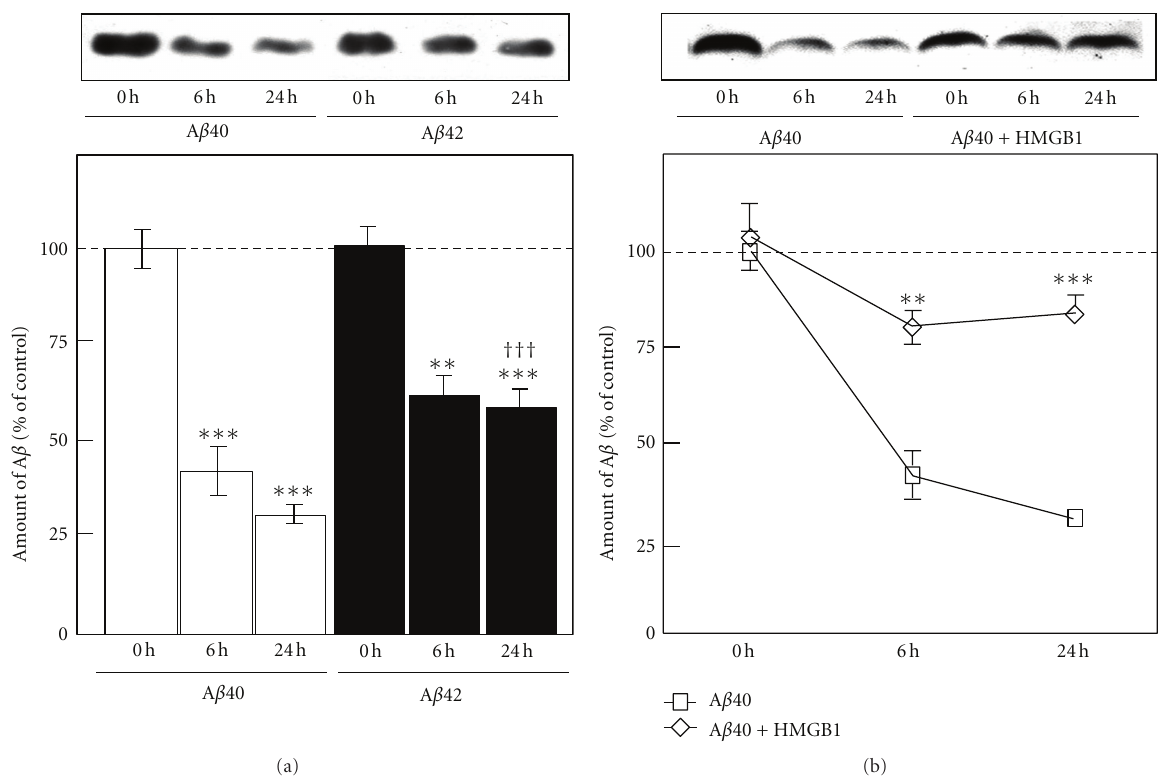
Figure 4: A β degradation with the microglial cytosolic fraction. (a) A β 40 and A β 42 were incubated with the rat microglial cytosolic fraction for 0, 6, and 24 h. After incubation, samples were subjected to Western blot analysis using the anti-A β antibody, and the amount of A β was semiquantitatively measured. ∗∗ P < 0 . 01, ∗∗∗ P < 0 . 001 versus time point 0h. ††† P < 0 . 001 versus A β 40 at time point 24 h. (b) A β 40 and A β 40 with HMGB1 were incubated with rat microglial cytosolic fractions for 0, 6, and 24 h. After incubation, the samples were subjected to Western blot analysis using the anti-A β antibody, and the amount of A β was semiquantitatively measured. ∗∗ P < 0 . 01, ∗∗∗ P < 0 . 001 versus A β 40 alone at each time